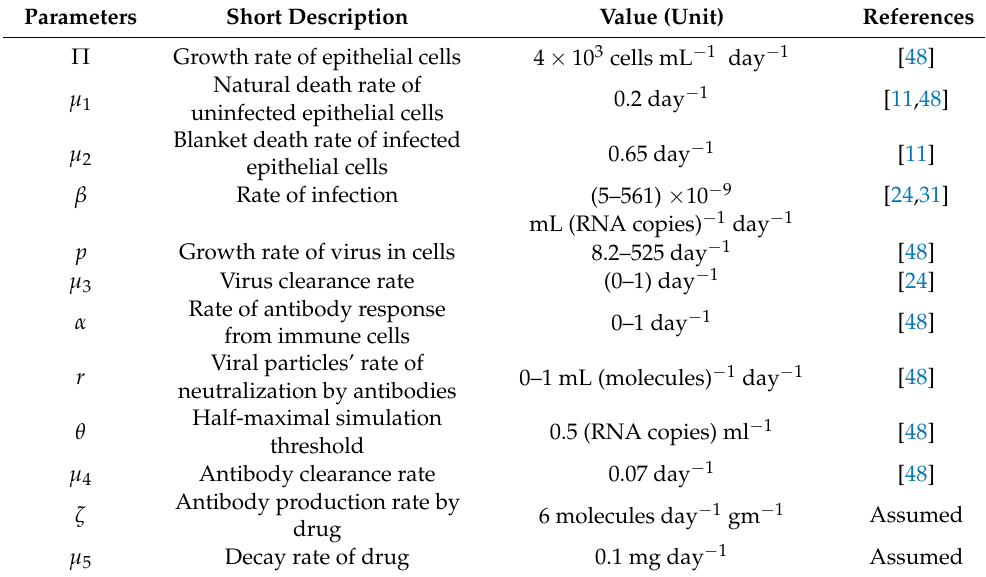
Table 1. Short descriptions and values of the parameters of Models (2) and (4).